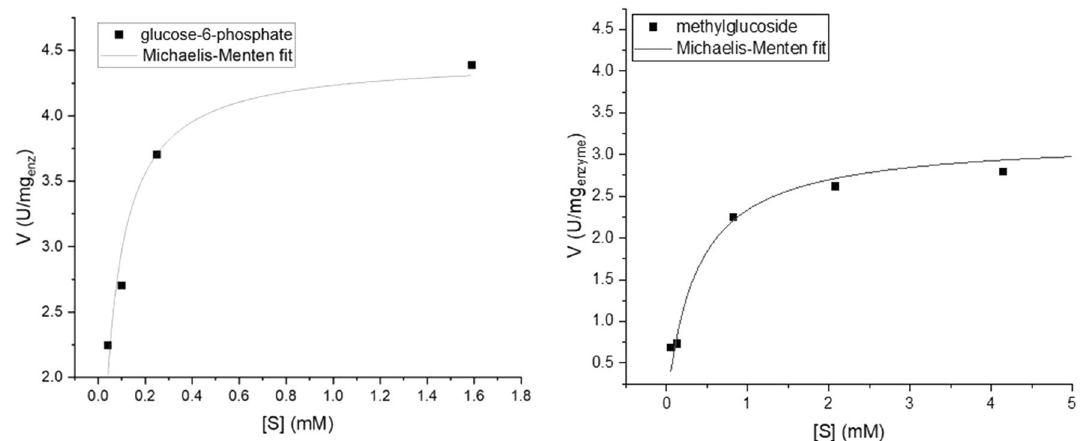
Figure 2. Michaelis–Menten (MM) graphs of glucose-6-phosphate (left) and methylglucoside